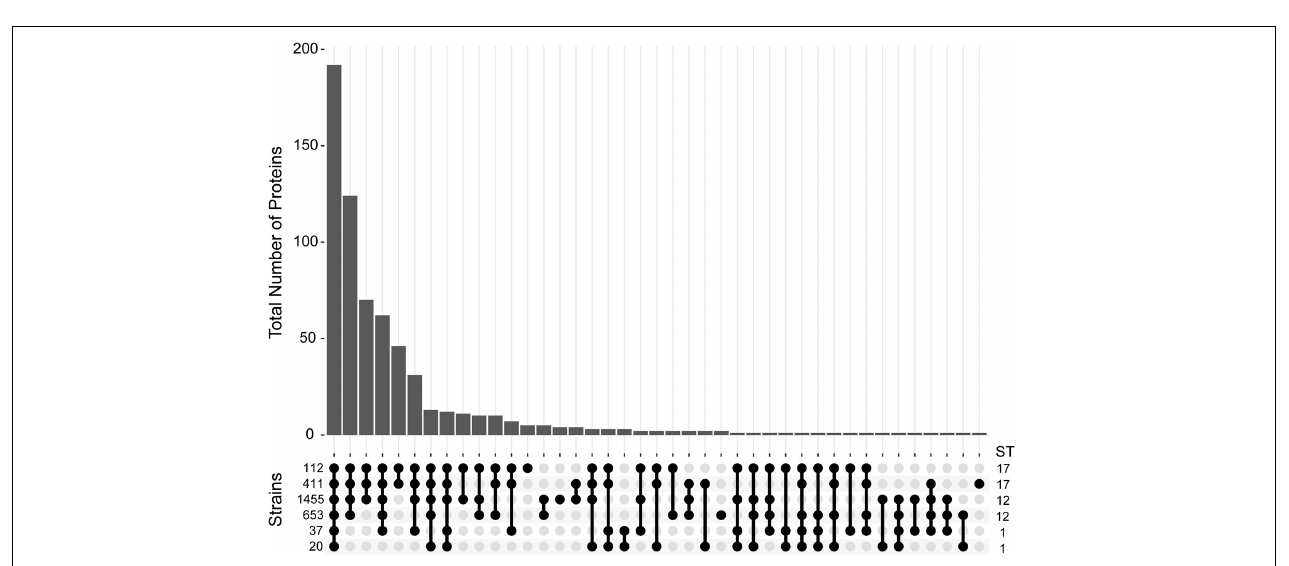
FIGURE 4 | Subcellular localization analysis of membrane vesicle (MV) proteomes. The subcellular localization of (A) all 643 MV proteins identified, and (B) a subset of 62 shared MV proteins identified using a pSORTdb database for published Streptococcus agalactiae sequences (accessed 3/3/21). Percentages were determined from mean spectral counts for a given sequence type (ST).